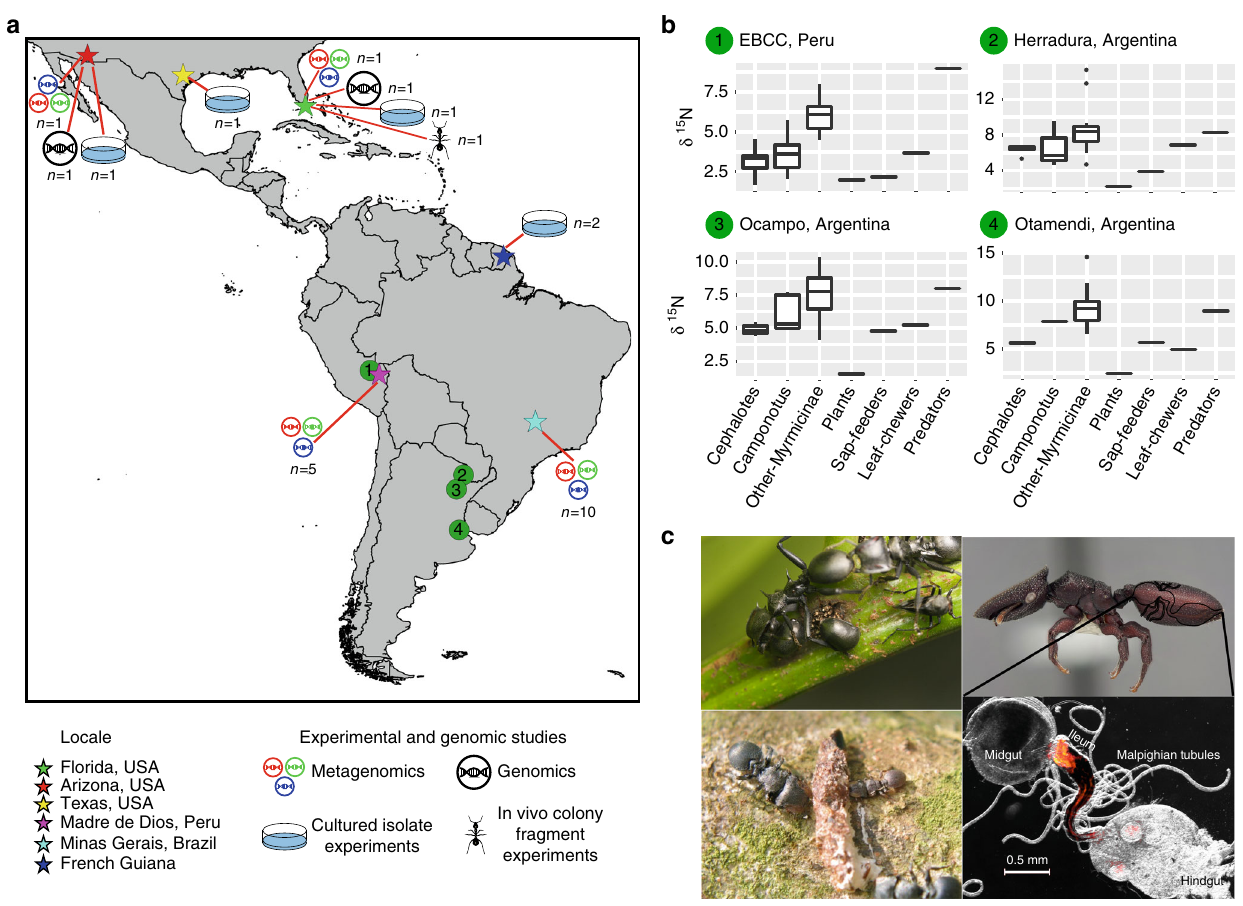
Fig. 1 Ecology of Cephalotes ants and origins of specimens used in our study. a Map showing sampling locales for cephalotines ( Cephalotes and Procryptocerus ) used in this study (stars), the activities they were used for, along with sample size (i.e., number of species). Numbered circles show sites of ant sampling in two prior studies 12,28 , from which stable nitrogen isotope data were extracted and plotted here. The map was constructed using an open source geographic information system QGIS software version 2.18. b Nitrogen isotope data from prior studies 14,31 targeting several New World locales. Each separate box plot graphs the median (center line), the interquartile range (i.e., from the top to the bottom of each box), values equal to 1.5 times the interquartile range (tops and bottoms of whiskers), along with outliers. Graphed are isotope ratios for Cephalotes ants, other ants in their subfamily (Myrmicinae), and Camponotus ants, which host known N-recycling bacteria. Also plotted are data for plants, insect herbivores, and insect carnivores from the same locales. Isotope fractionation results in a gradual increase in the relative amounts of heavy nitrogen ( 15 N), as one moves up the food chain. As such, ants with low amounts of the heavy nitrogen isotope, shown here using the δ 15 N statistic, are argued to feed at low trophic levels. c C. atratus workers tend honeydew-producing, ant-mimicking membracids (upper left, image credit: Jon Sanders). C. eduarduli and C. maculatus (smaller worker) feeding on bird droppings (lower left, from Fig. 2b of Russell et al. 16, used with permission from Myrmecological News and photographer Scott Powell). Soldier caste of C. varians with an outlined digestive tract (upper right, image credit: Corrie Moreau). A FISH microscopy image of a digestive tract from a Cephalotes worker is shown at lower right (image credit: Piotr Lukasik). Note the large bacterial mass in the ileum near the midgut – ileum junction, the site where N wastes